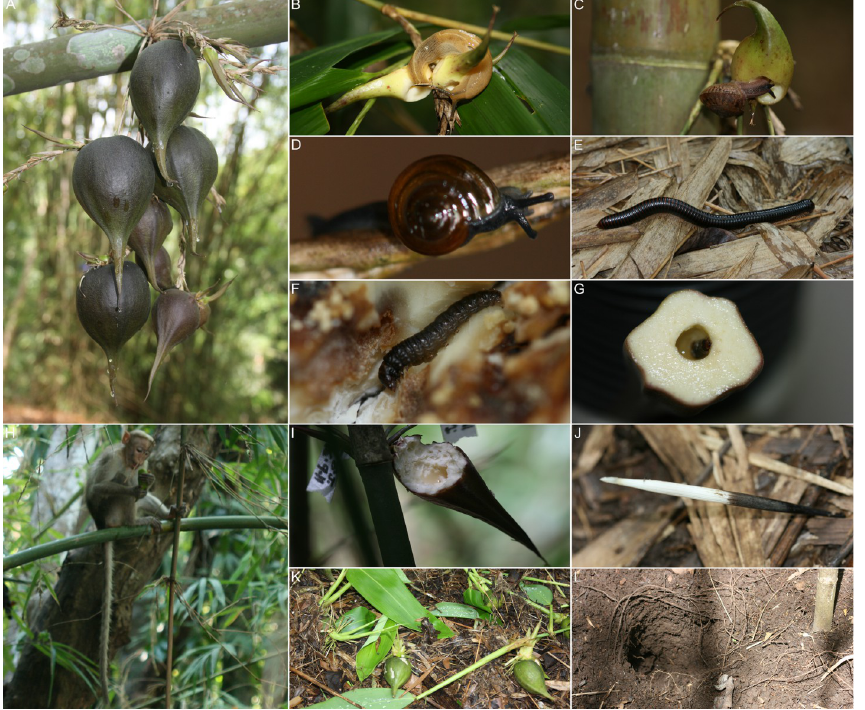
Fig 3. M . baccifera fruits, predators. A. Fruits, B-L fruit predators, B-D. Slugs and snails, B. M . dussumieri , C. C . bistrialis , D. Macrochlamys sp., E. Millipede S . colosseus , F-G Fruit borers, F. Larvae of A . grisella , G. Larvae of B . germanica , H-L Mammals, H. Bonnet macaque, M . radiata , I. Fruit bitten by rats R . rattus , J. Quill of porcupine H . indica , K. Seedlings spoilage by wild boars S . scrofa , L. Soil rooting by S . scrofa . delicacy in Mizoram (locally ‘Thangnang’), associated with M . baccifera gregarious flowering [2, 28], was not observed in the study clumps. Fruit predators. Slugs , snails . One slug species ( Mariaella dussumieri ) and two snail species ( Cryptozona bistrialis , Macrochlamys sp.) were found attacking young fruits. It was observed that the swollen soft pericarps of immature fruits were pierced or chewed by slugs and snails during rainy and/or wet days, and they drank the liquid inside the fruit. Fruits attacked by slug/snail left characteristic depressions or cavities on fruit pericarps which were easily recognizable (Figs 3 and 4 and S8(A)-S8(F), S9(A)-S9(C), S10(A)-S10(D) Figs in S1 File and Table 1). Of the total 2590 fruits surveyed in clump 58, from August 2010 to August 2011, 161 fruits (6.22%) were predated by slugs and snails (S9 Table in S1 File). Fruits at the age of 1–7 days (1 st week) registered 4.88% (25 out of 512 fruits), 8–14 days (2 nd week) 10.73% (63/587) and 15–21 days (3 rd week) 11.91% (68/571) hits. Slug/snail attack was negligible (0.54%; 5/920) in 4, 5 and 6 week old fruits (Fig 5A and S9 Table in S1 File). Maximum slug/snail attack was observed in the rainy months of July 2011 (13.57%; 38/280), June 2011 (10.43%; 34/326) and August 2010 (8.84%; 42/475). Slug/snail predation was also observed in clump 359 from May 2009 to December 2011. Of the total 3481 pre- dated fruits, slugs and snails attacked 134 (3.85%) fruits. June-July registered highest hits, 18 out of 134 (13.43%) in 2009, 38 (28.36%) in 2010 and 34 (25.37%) fruits in 2011. This is followed by August with 3.73% (5 fruits) in 2009, 2.24% (3) in 2010 and 7.46% (10) in 2011 (S10 Table in S1 File). Thus, slug/snail predation is mostly confined to 1 to 3 week fruits and wet/rainy seasons (Figs 4 and 5A and Table 1).